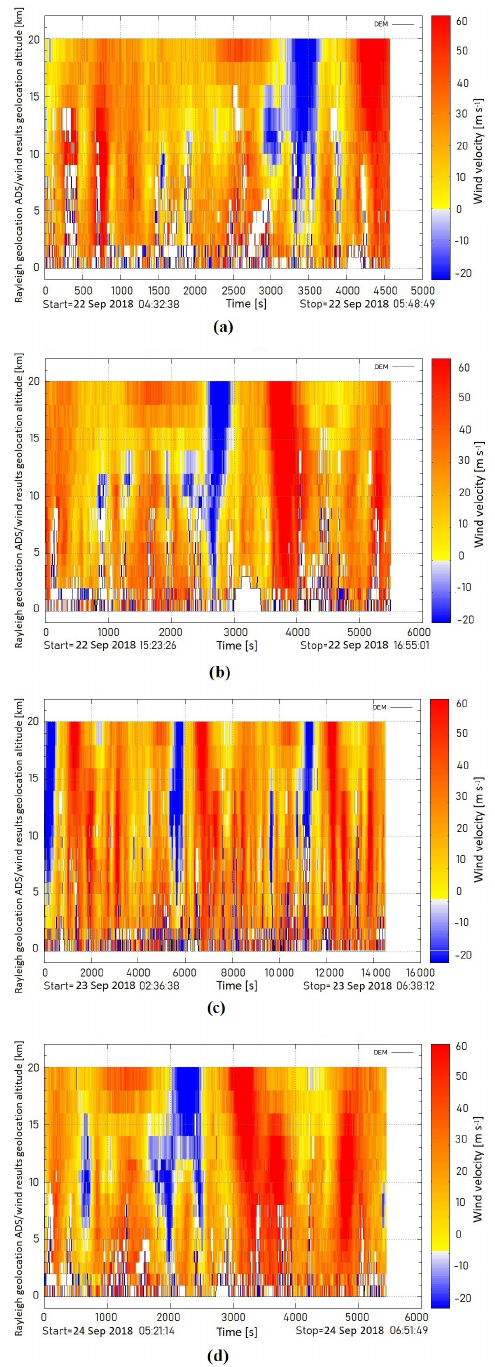
Figure 5. Aeolus Rayleigh scattering observations of wind pro- files up to 20km. The MDS wind profiles (positive towards the instrument) measured during orbit numbers 513 and 514 on 22– 24 September 2018 between 04:32 and 06:51UTC using the MDS Rayleigh scattering. The blue areas indicate zones during which the wind speed variations introduced by the Rayleigh response fluctu- ations are negative. Random error (1 σ ) is 1ms − 1 at altitudes less than 2km and 2ms − 1 between 2 and 16km. Systematic error (1 σ ) is smaller than 0.7ms − 1